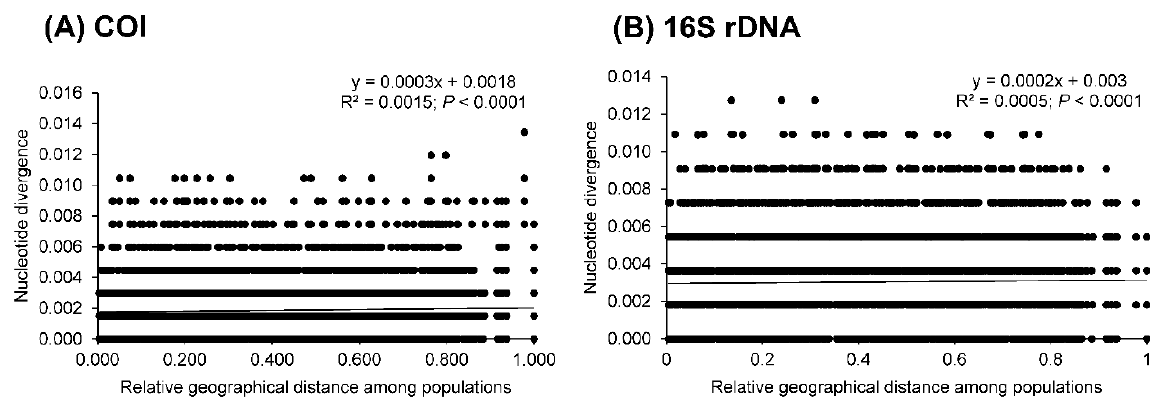
Figure 5. Relationships of nucleotide divergences to relative geographical distances between populations in the hilly lineage